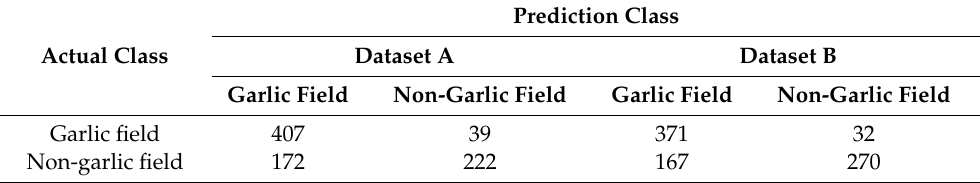
Table 14. Confusion matrix of classification model generated using the MLC method.